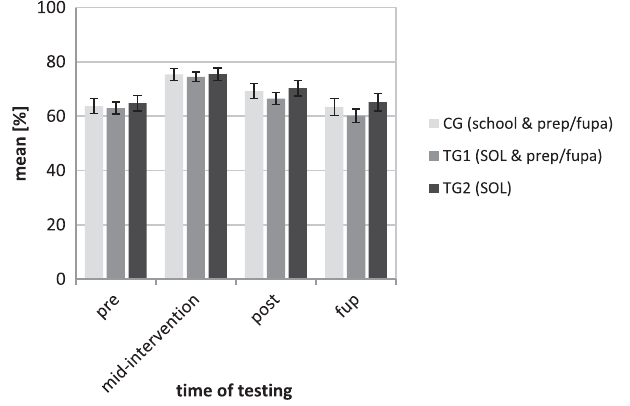
FIG. 8. Descriptive data of the subscale self-concept with standard error of the